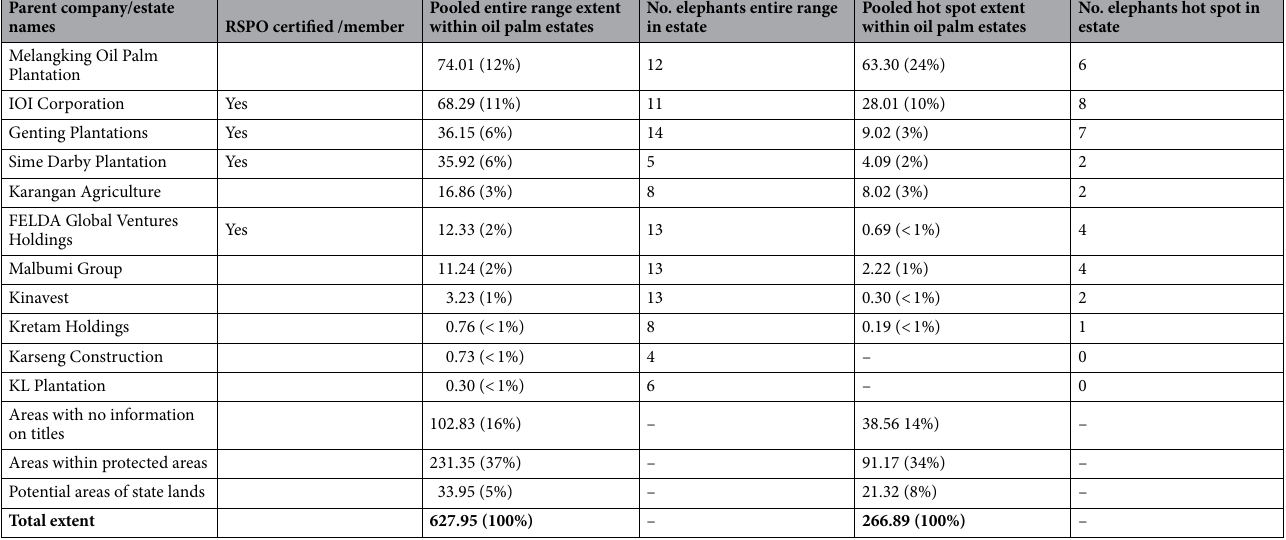
Table 7. Extents (km 2 ) and proportions (%) of elephants entire range and hot spots within known oil palm estates, along with the companies RSPO membership status and number of collared elephants entire range and/or hot spots within estate boundaries. Table also shows extents within: unknown land tiles, protected areas, and in potential state lands.